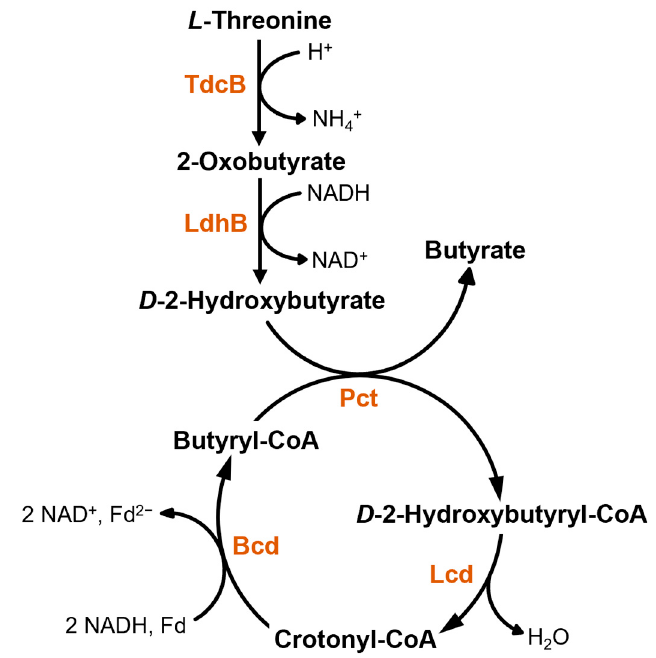
Figure 4. Proposed pathway for butyrate formation in Anaerotignum strains (based on [19]). TdcB, L -threonine dehydratase (CLNEO_20890, CPRO_03900); LdhB, L -lactate dehydrogenase (CLNEO_01790, CPRO_00680); Pct, propionate CoA-transferase (CLNEO_17700, CPRO_08400); Lcd, lactoyl–CoA dehydratase (CLNEO_17710-17730, CPRO_08370-08390); Bcd, butyryl–CoA dehydrogenase (CLNEO_29840-29850 or CLNEO_21740-21760, CPRO_28160-28180).